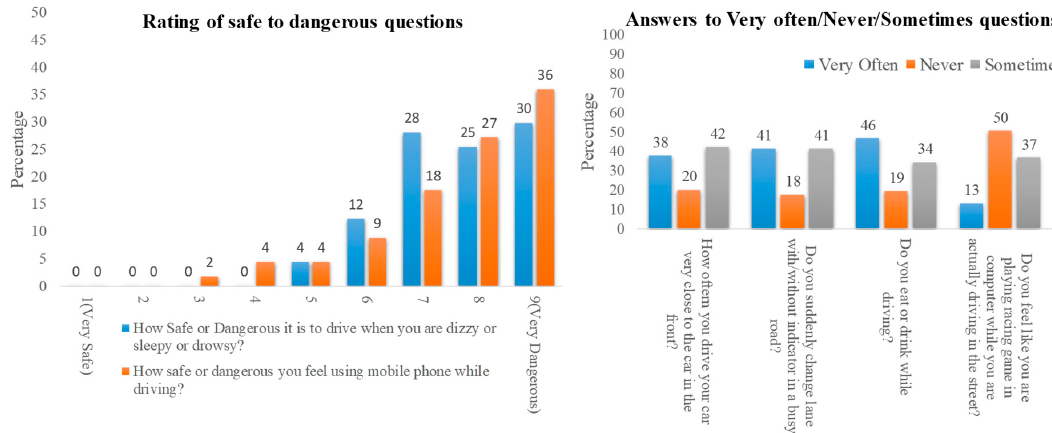
Figure 14. ( A ) Statistics for the rating of safe to dangerous questions and ( B ) results for some very